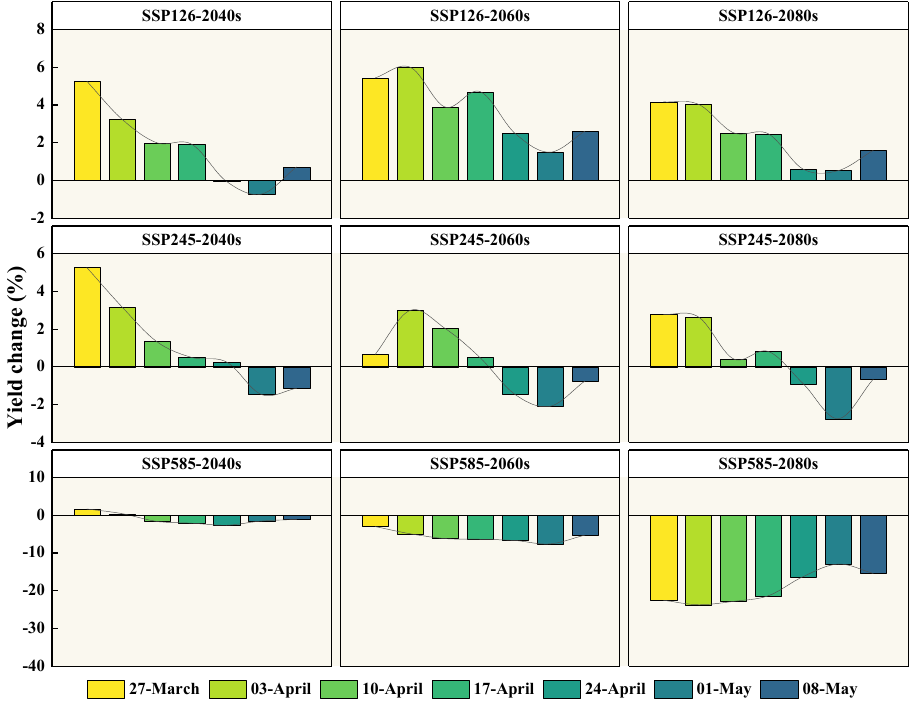
Figure 10. Simulated change in rice yield under different sowing dates in the 2040s, 2060s, and 2080s under SSP126, SSP245, and SSP585 scenarios based on the six GCMs compared with sowing on 17 April 2000–2019 for Qing’an station in the Songnen Plain.